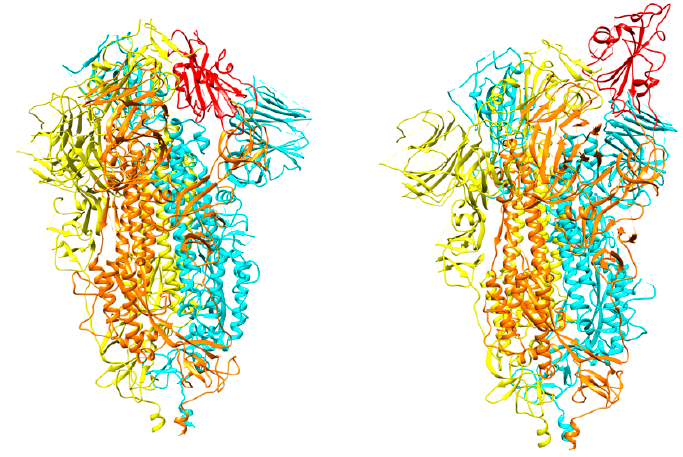
Figure 3. The spike protein trimer in the two conformations: “down” ( left ) and “up” ( right ). The moving receptor-binding domain (RBD) in monomer B is shown in red. Each monomer is colored differently with A, B, and C in yellow, orange, and cyan, respectively (PDB ids 6vxx and 6vyb).